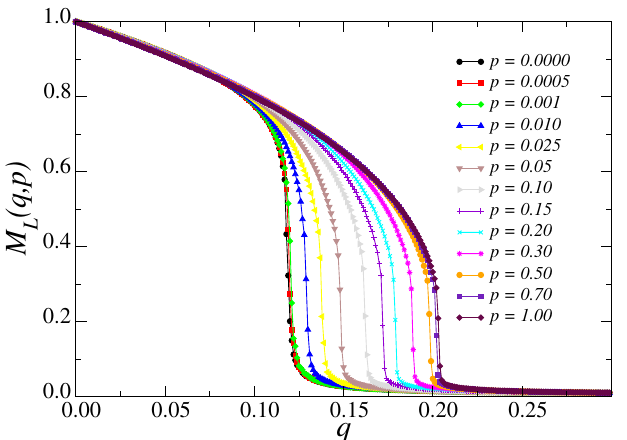
Figure 4. Average magnetization M L ( q , p ) as a function of the noise parameter q for several values of the rewiring probability p and L = 140 . For each value of p , M L ∼ O ( 1 ) for q < q c ( L ) and M L ∼ 0 for q > q c ( L ) . The error bars are smaller than the symbol size, and the lines are just a guide to the eyes.